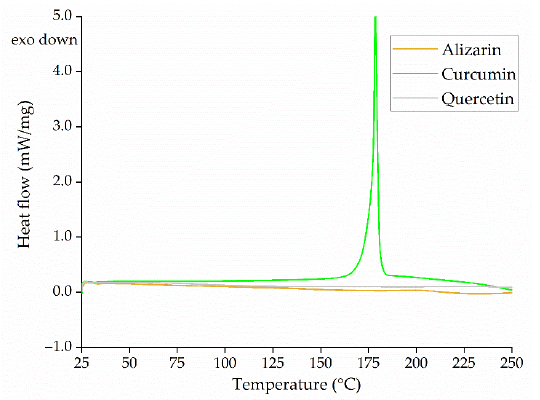
Figure 8. DSC thermogram representing dyes at different temperatures, showing an endothermic peak for curcumin.